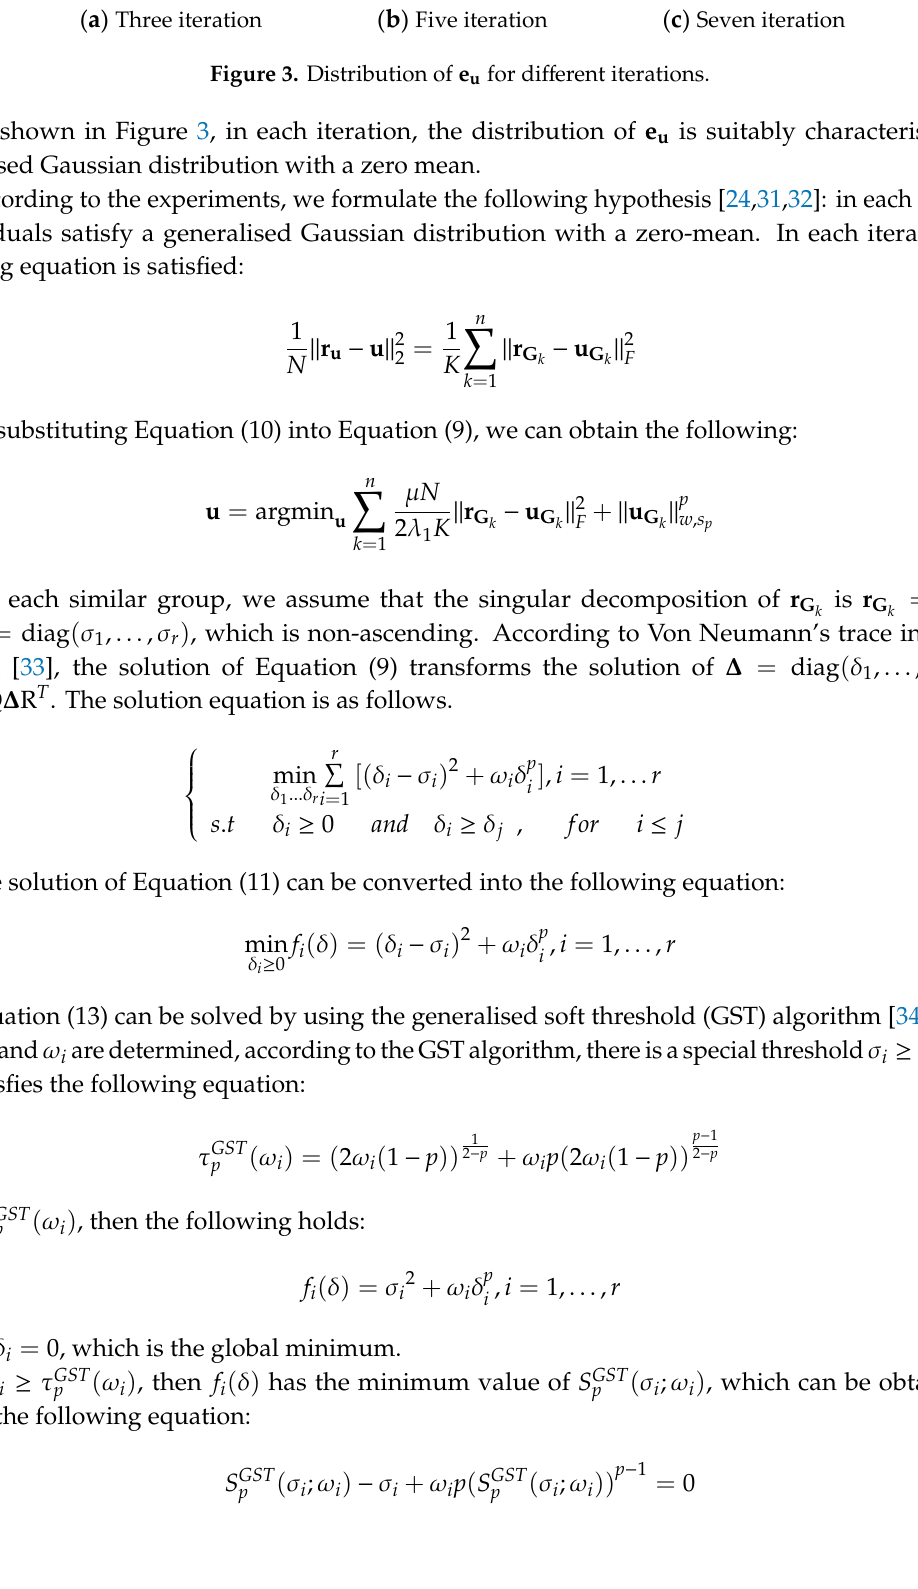
Figure 3. Distribution of u e for different iterations.